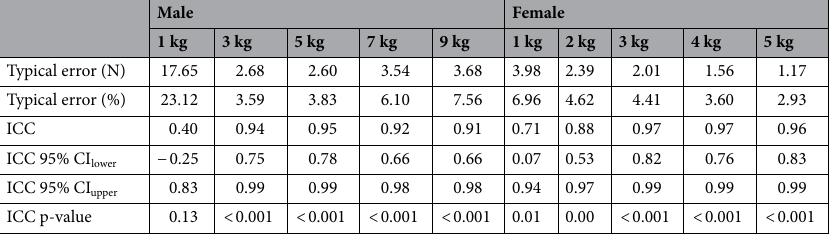
Table 2. Test–retest absolute typical error, typical error relative to the mean and the intra-class correlation coefficients obtained from the active drag calculation. ICC, Intra-class correlation coefficient; 95% CI lower , lower bound of the 95% confidence interval; 95%CI upper , upper bound of the 95% confidence